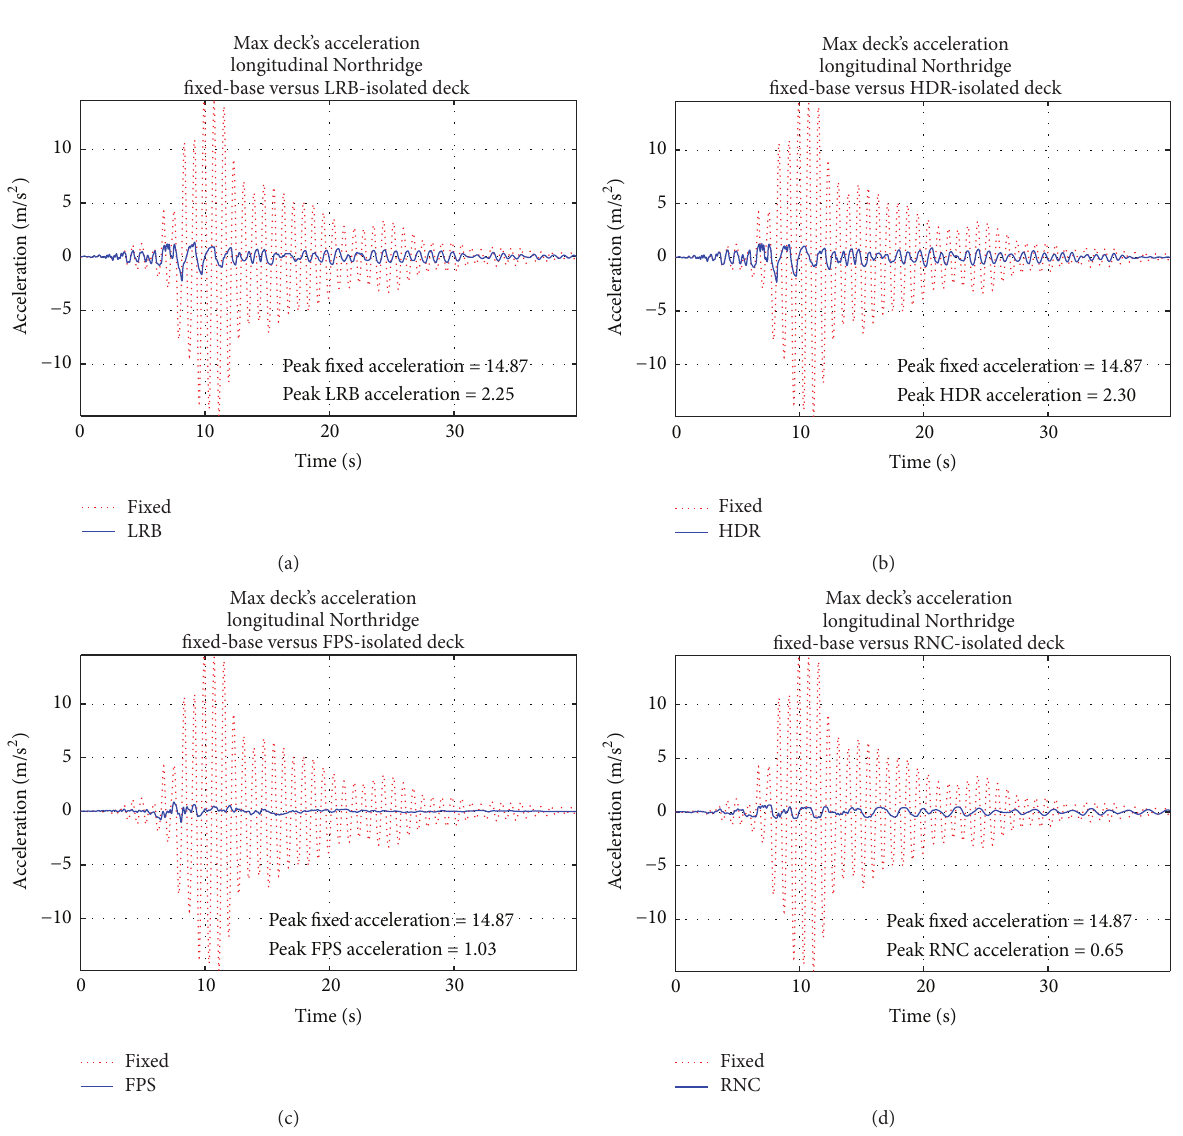
Figure 14: The deck’s peak acceleration time histories under longitudinal Northridge earthquake using (a) LRB; (b) HDR; (c) FPS; (d)